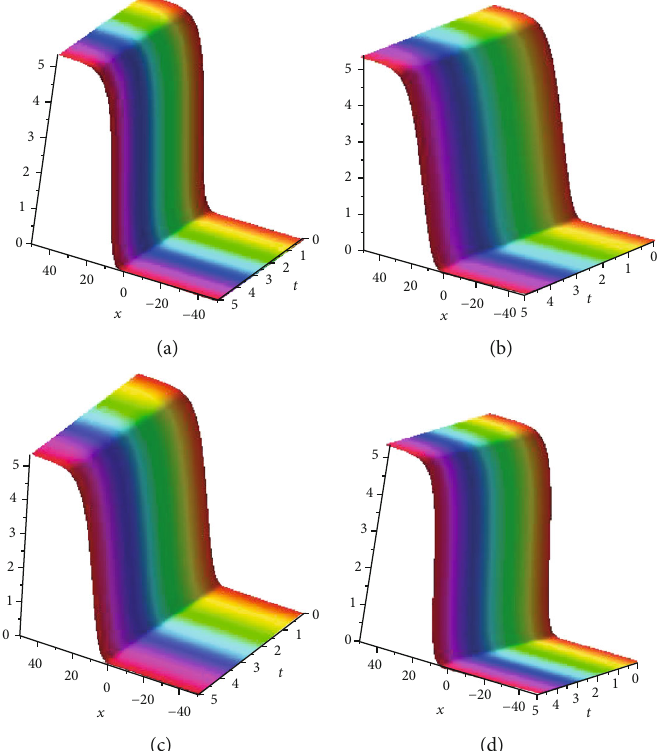
= 1 : 5 , r = 2 , λ = 2 : 2 , M = 3 , N = 2 , and k = 3 when (a) α = 0 : 25 , (b) α = 0 : 5 , (c) α = 0 : 85 , 2 2